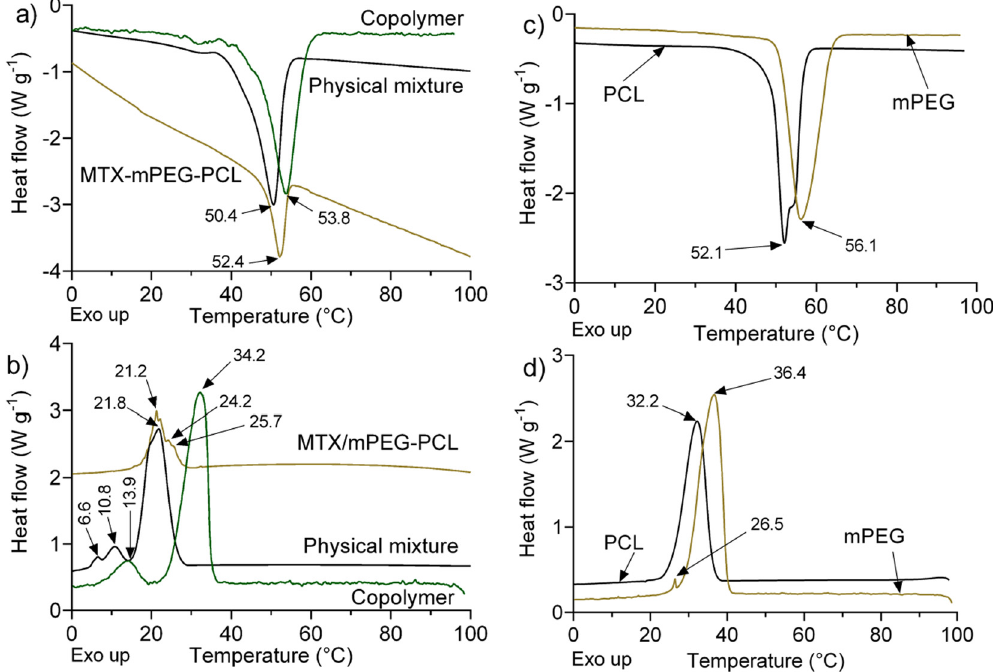
Figure 6: DSC traces of ( a ) fusion and ( b ) crystallization of copolymer ( mPEG - PCL ) , physical mixture ( mPEG - PCL + MTX ) , and methotrexate - loaded micelles ( MTX/mPEG - PCL ) and ( c ) fusion and ( d ) crystallization of polycaprolactone ( PCL ) and m - polyethylene glycol ( mPEG )